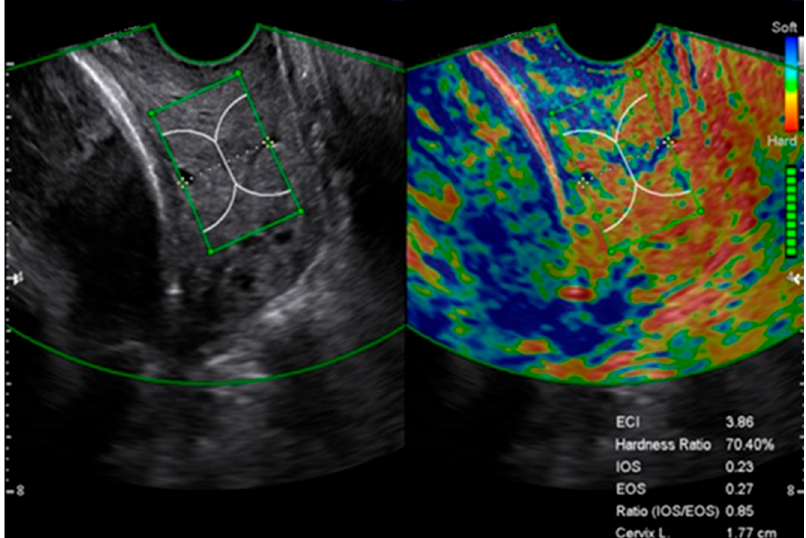
Figure 1. Cervical elastography image obtained from a short cervix using E-cervix TM . Acquisition of cervical elastography was performed in the mid-sagittal plane when measuring cervical length. Elastographic parameters and cervical length (CL) are displayed on the bottom left of the image. ECI, elasticity contrast index; EOS, mean of external os strain; HR, hardness ratio; IOS, mean of internal os strain.